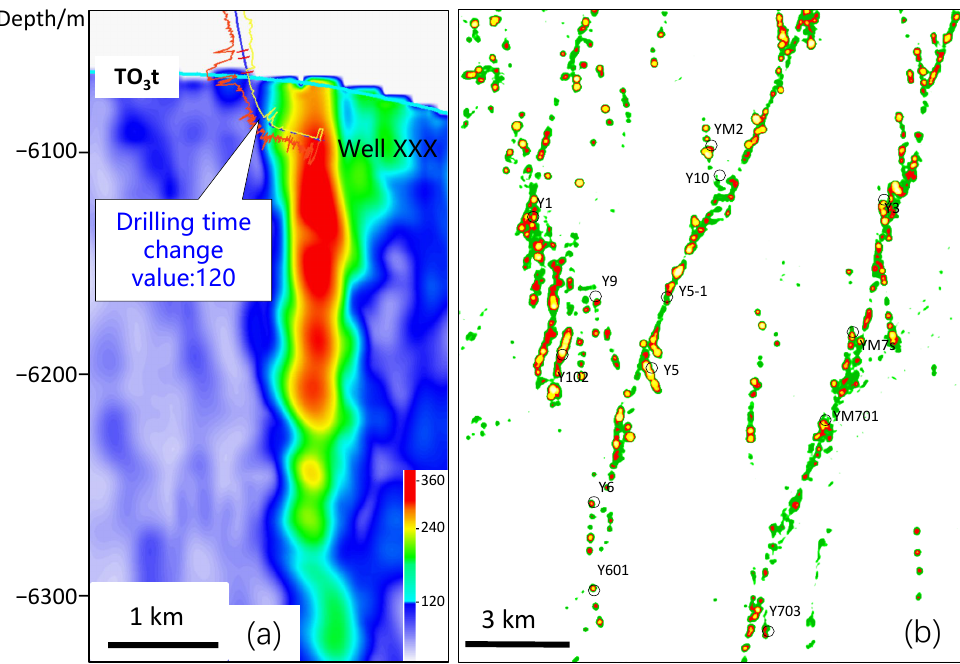
Figure 4. ( a ) Tensor thickness attribute sections and related well drilling times showing the boundaries of the fault damage zones and the fracture-cave reservoir (the boundary in the tensor thickness amplitude value is consistent with the drilling time curve); ( b ) plane amplitude change rate showing fracture-cave reservoirs overlapped with strike-slip faults in the Fuman Oilfield (bright yellow patches are fracture-cave reservoirs).